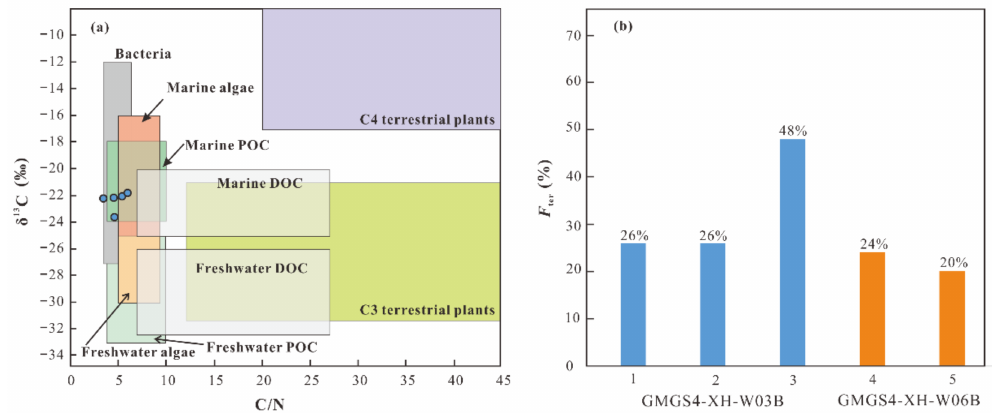
Figure 7. ( a ) Source indication inferred from the δ 13 C values and C/N ratios of organic matter. Adapted with permission from ref. [28]. Copyright 2006 Clearance Center; ( b ) calculated percentages of terrestrial organic matter ( F ter ) in sediments. POC and DOC denote particulate organic carbon and dissolved organic carbon,